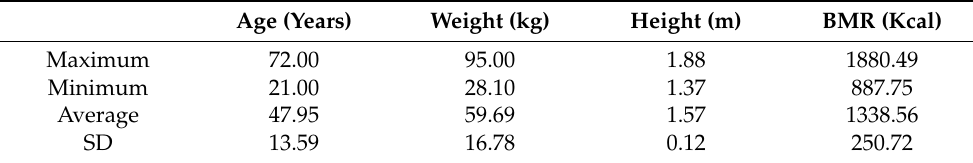
Table 2. Summary of patients’ physiological